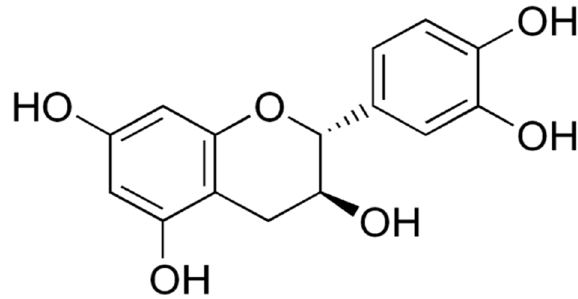
Figure 1. Chemical structure of catechin or (+) catechin hydrate.